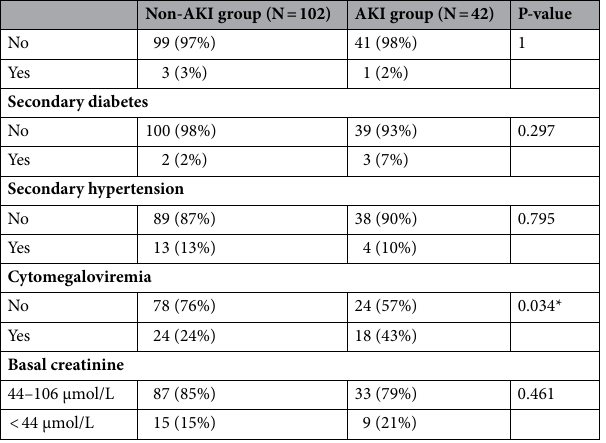
Table 2. Comparison of clinical data between AKI group and non-AKI group. Tacrolimus (FK506), acute graft versus host disease (aGVHD), hemorrhagic cystitis (HC), total body irradiation (TBI), cyclosporin